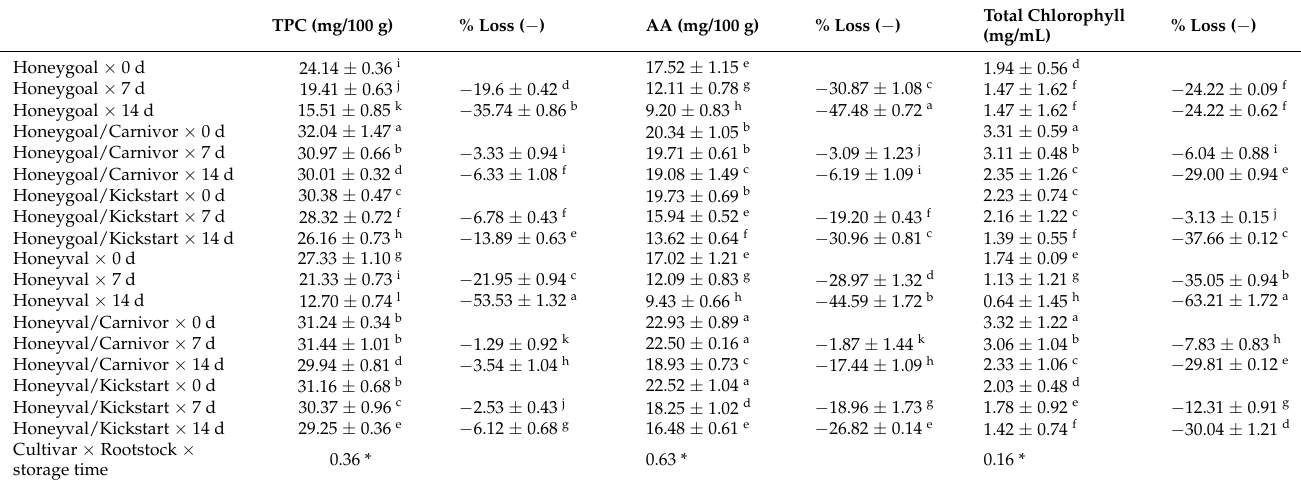
Table 1. Changes in total phenol, ascorbic acid and total chlorophyll of grafted and un-grafted honeydew melon cultivars during postharvest